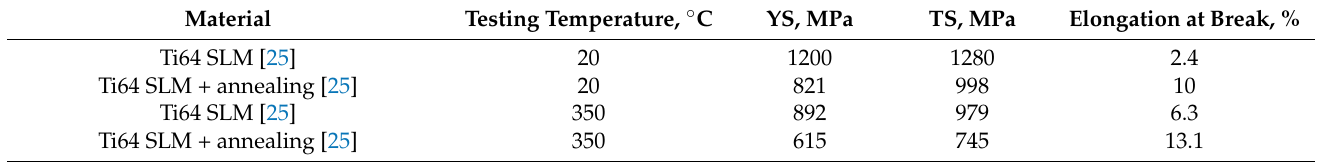
Table 1. Tensile properties of Ti64, Ti 2 AlNb alloys and Ti 2 AlNb/Ti-6Al-4V bimetallic structures.